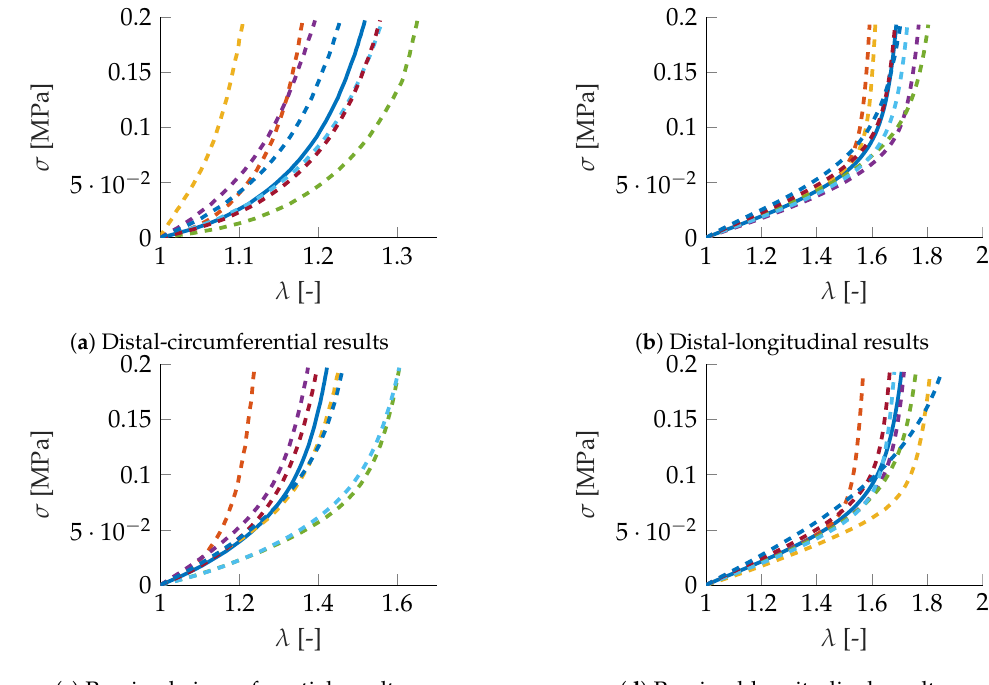
Figure 4. Experimental ( a ) distal-circumferential, ( b ) distal-longitudinal, ( c ) proximal-circumferential, and ( d ) proximal-longitudinal stress–stretch curves. The continuous blue line represents the mean values of the 14 experimental results, while the dashed lines represent the neighboring experiments, as found by TDA